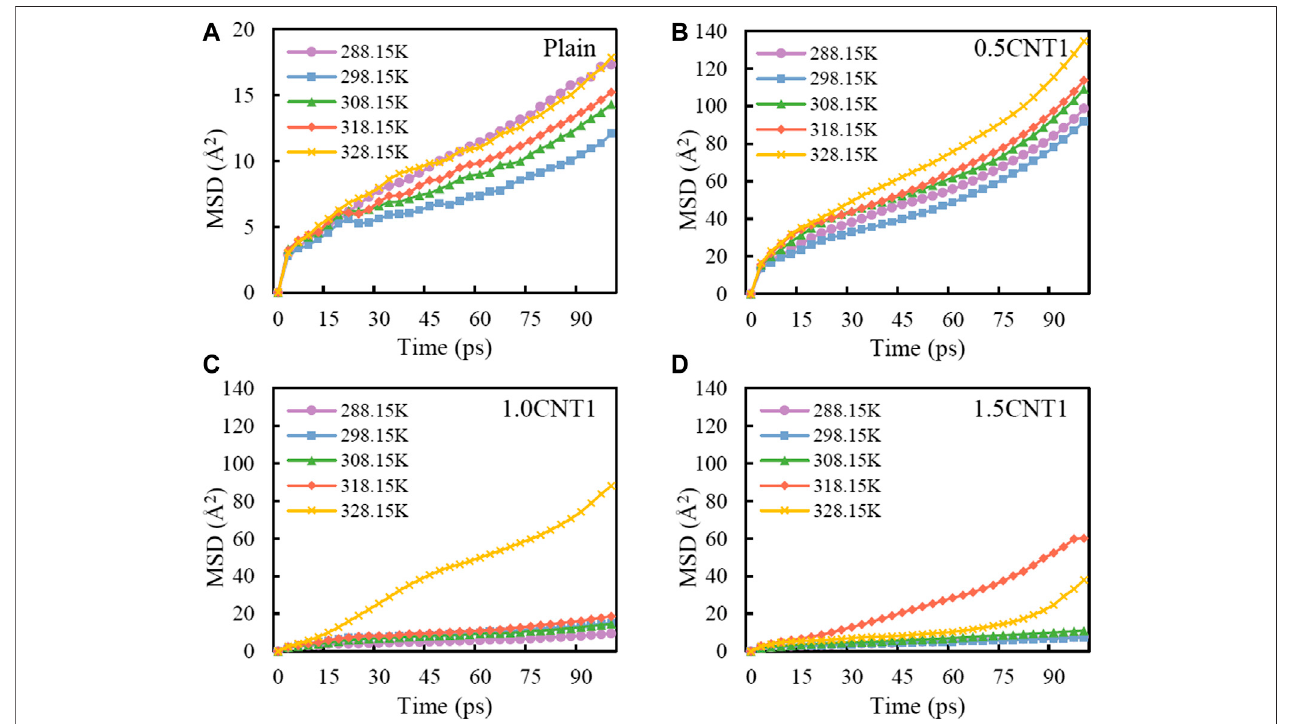
FIGURE 5 | Mean square displacement of the healing process of CNT1 modi fi ed PEN70 asphalt: (A) plain; (B) 0.5% CNT1; (C) 1.0% CNT1; (D) 1.5% CNT1.